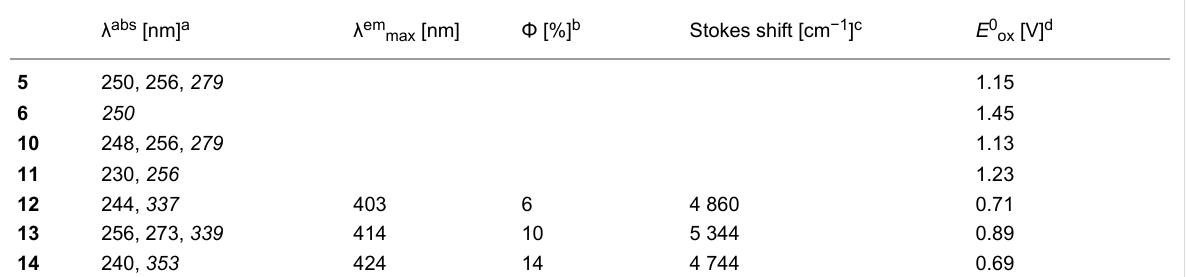
Table 3: Spectroscopic and electrochemical characterization of 5 , 6 and 10 – 14